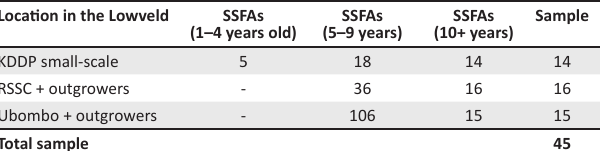
TABLE 1: Small-Scale Famers Associations in the study area ( n = 45). Location in the Lowveld